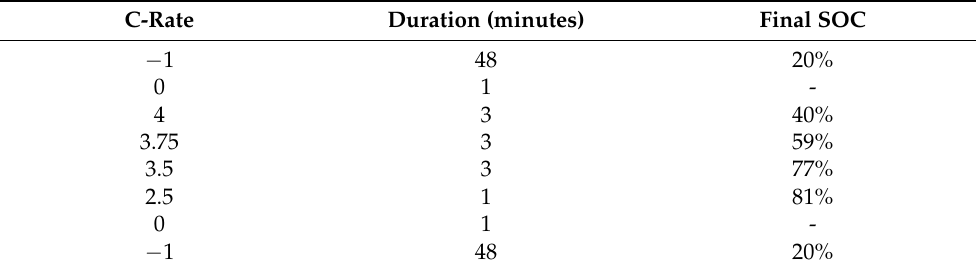
Table 5. Highway—Fast Charge—Highway (HFCH) driving cycle C-rates and SOC. Negative C-Rate indicates the discharge period (hence with negative current). The two sections with 0 c-rate stand to represent the actual stops that the user would take before and after charging the